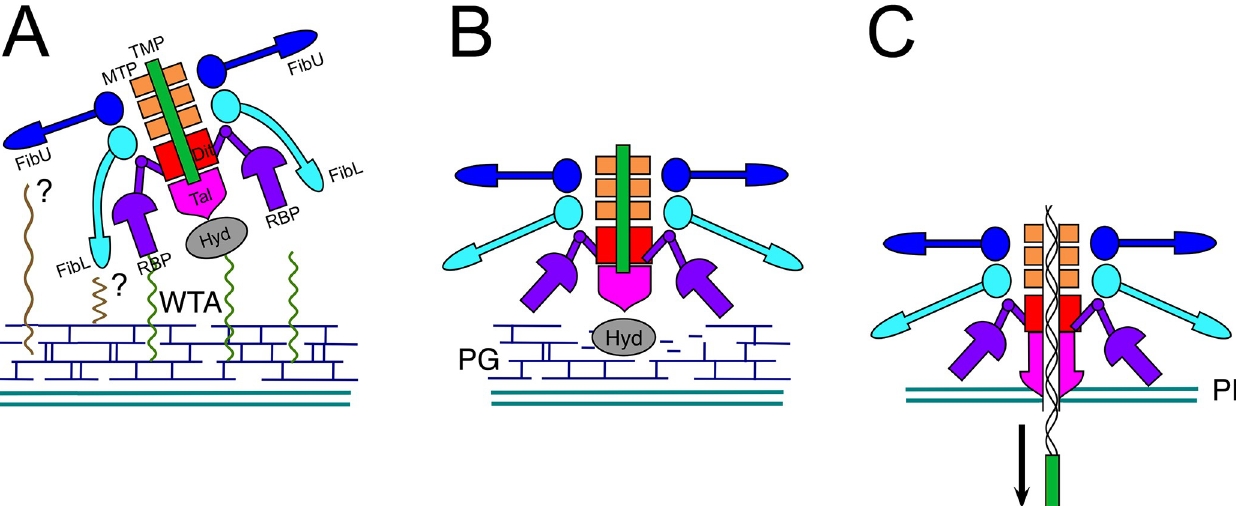
Fig 6. Model for conformational changes in the baseplate during the infection process. (A) Initial binding of RBP to WTA. FibL and FibU may also be involved in binding to other, as yet unidentified surface structures (?). (B) Conformational changes in RBP lead to exposure of enzymatic activities associated with Hyd and Tal, allowing degradation of the cell wall peptidoglycan (PG). (C) Penetration of the plasma membrane (PM) by the Tal rod helices triggers release of TMP, leading to ejection of DNA through the central channel.